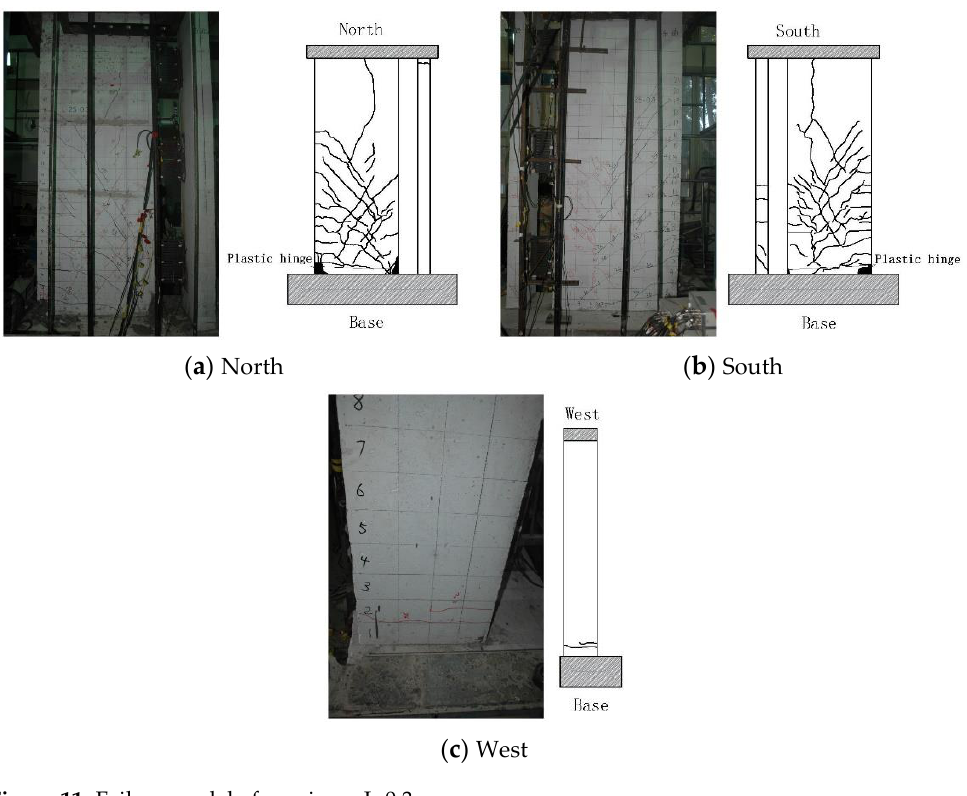
Figure 11. Failure model of specimen L-0.3.